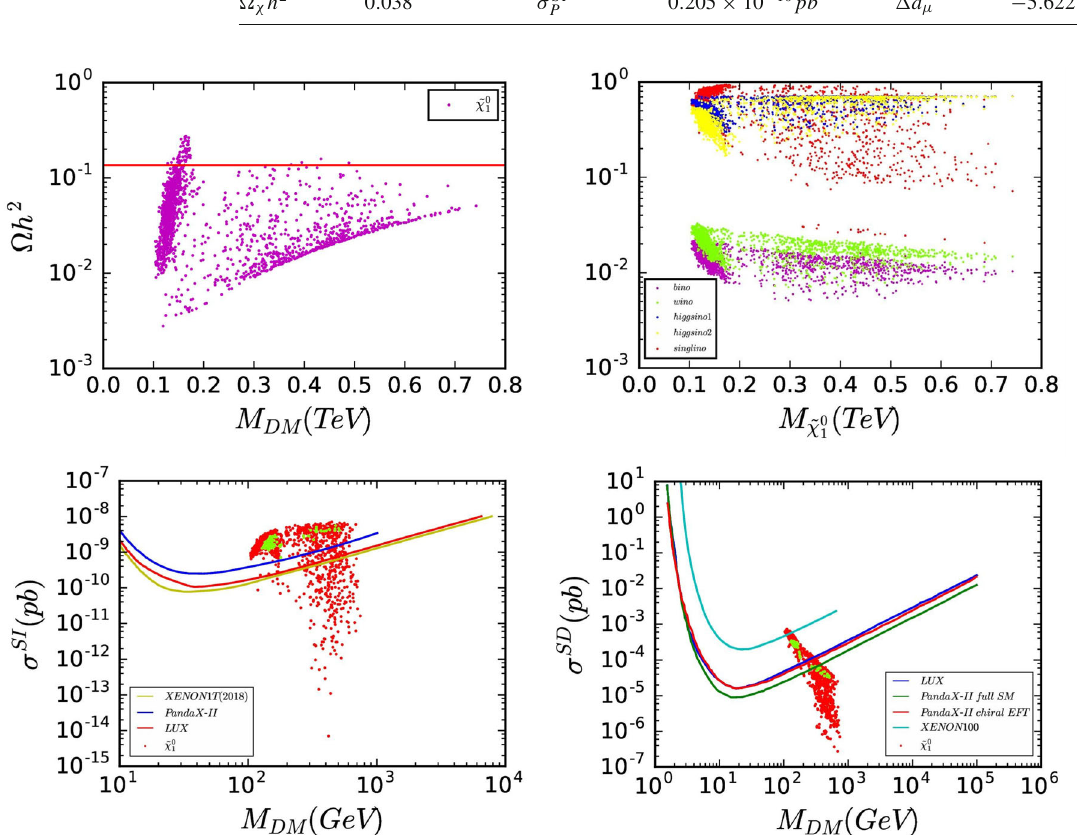
Fig. 3 Relicdensity of the neutralino DM versus the DM mass is given in the upper left panel. The ingredients of the neutralino DM is shown in the upper right panel. The spin-independent cross section σ SI (left) and the spin-dependent cross section σ SD (right) versus DM mass for DM